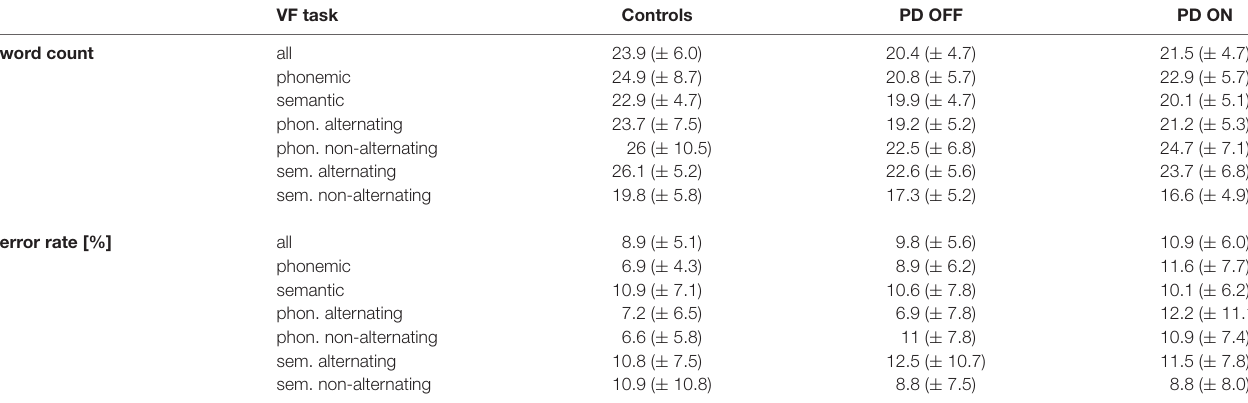
TABLE 2 | VF task performance and accuracy.